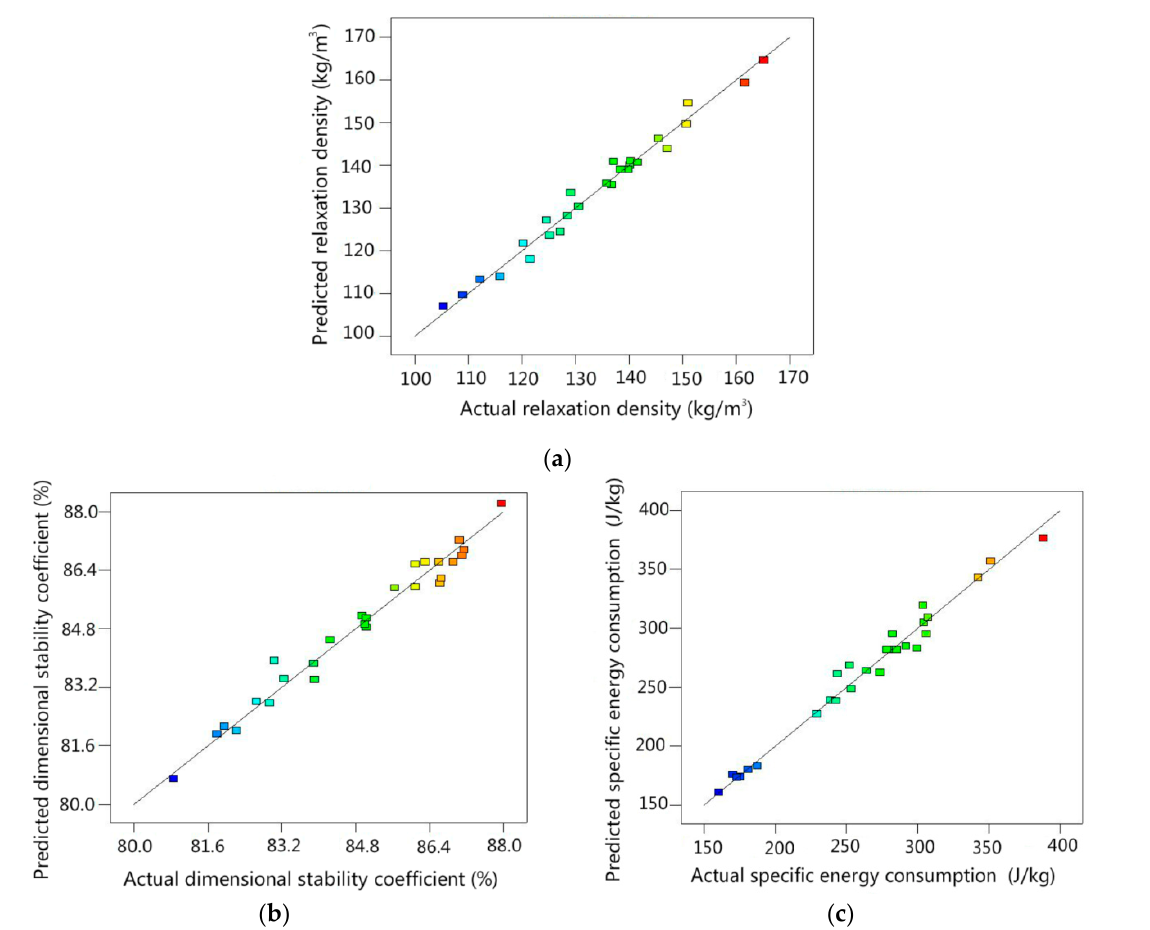
Figure 3. Predicted vs. actual values of compression indicator ( a ) Predicted vs. actual values of relaxation density. ( b ) Predicted vs. actual values of dimensional stability coefficient. ( c ) Predicted vs. actual values of specific energy consumption . Table 5. Response model fit summary output for relaxation density, dimensional stability coefficient and specific energy consumption.